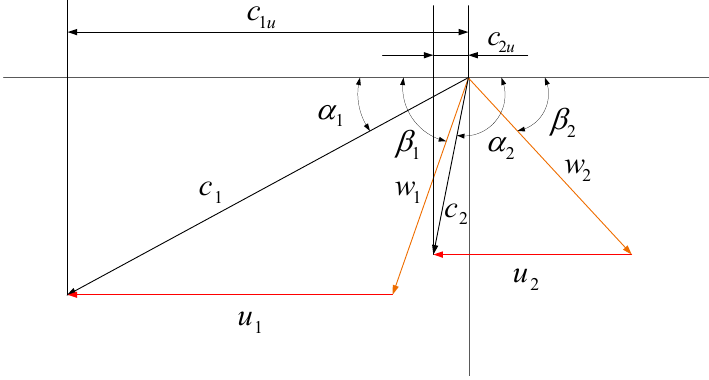
Figure 1. Velocity triangles of radial ‐ inflow turbine.